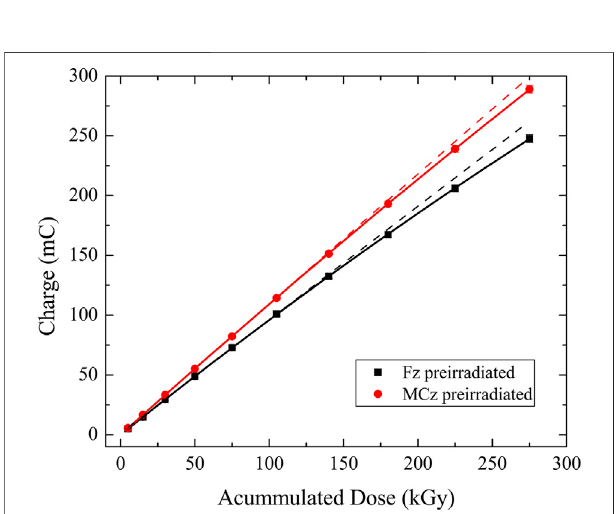
FIGURE 9 | Dose-response curves of the preirradiated Fz and MCz diodes covering the dose range of 275 kGy. A second-order polynomial function best fi ts the data. For comparison, the dashed lines show the departure from linearity in the high-dose region.